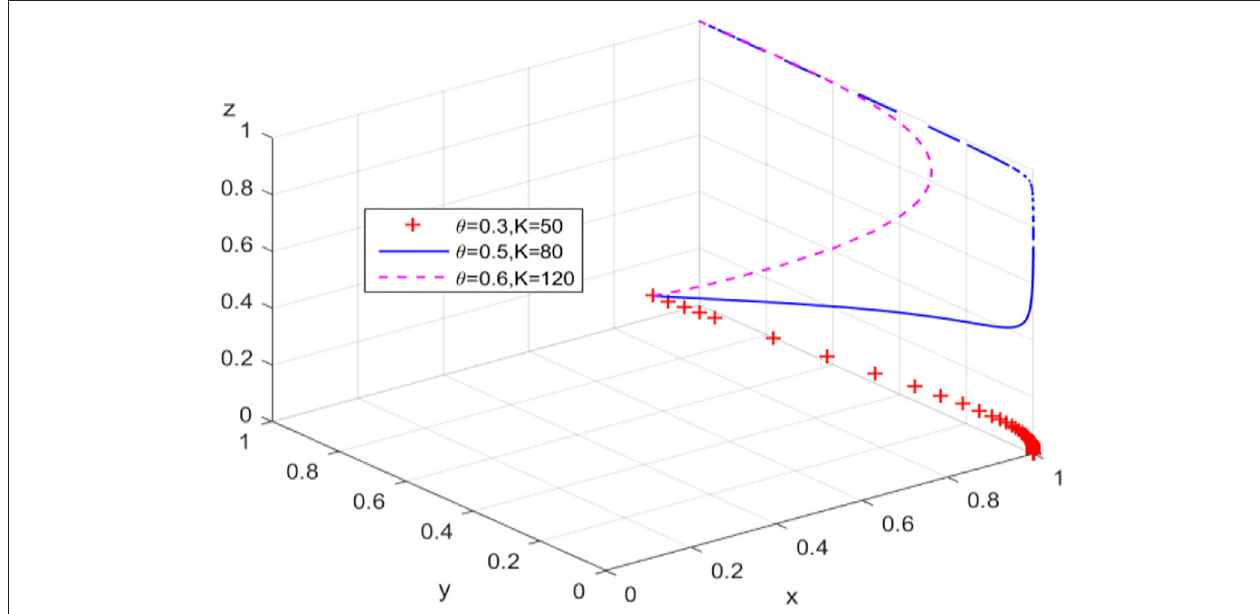
FIGURE 5 | The breakthrough effect of path 4 on low-level